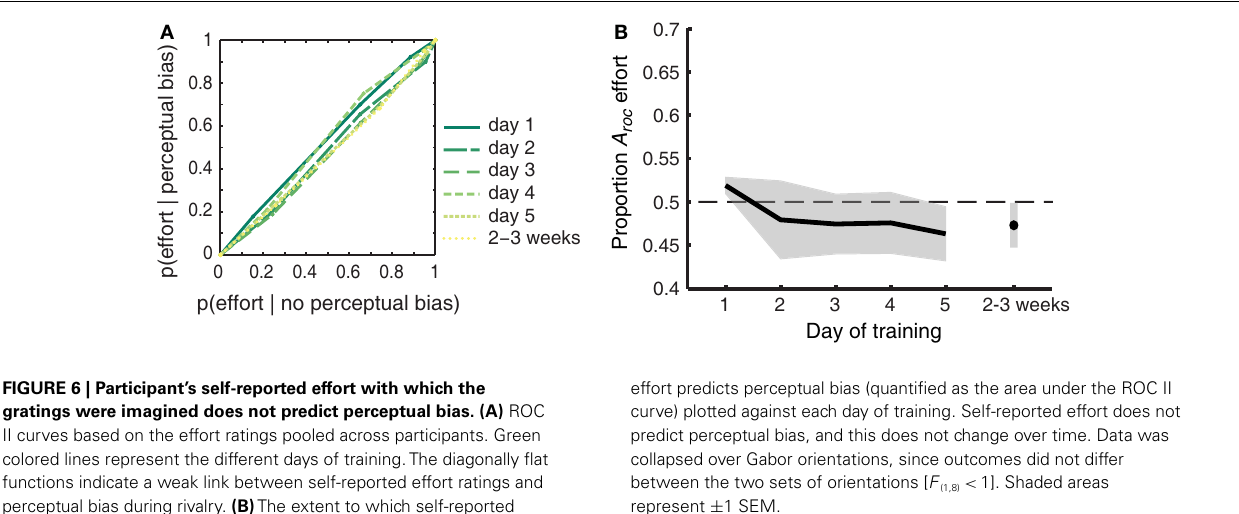
FIGURE 6 | Participant’s self-reported effort with which the gratings were imagined does not predict perceptual bias. (A) ROC II curves based on the effort ratings pooled across participants. Green colored lines represent the different days of training.The diagonally flat functions indicate a weak link between self-reported effort ratings and perceptual bias during rivalry. (B) The extent to which self-reported